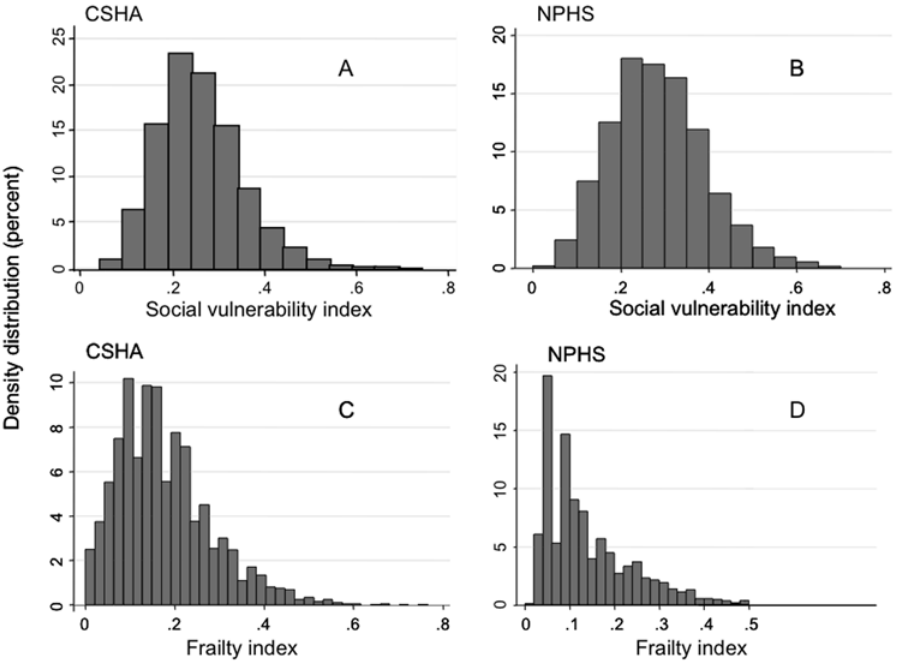
Figure 2. Distributions of social vulnerability: A) Canadian Study of Health and Aging (CSHA), B) National Population Health Survey (NPHS) and frailty: C) CSHA, D) NPHS. While some individuals scored ‘‘zero’’ on the frailty index, no individual was completely free of social vulnerability.